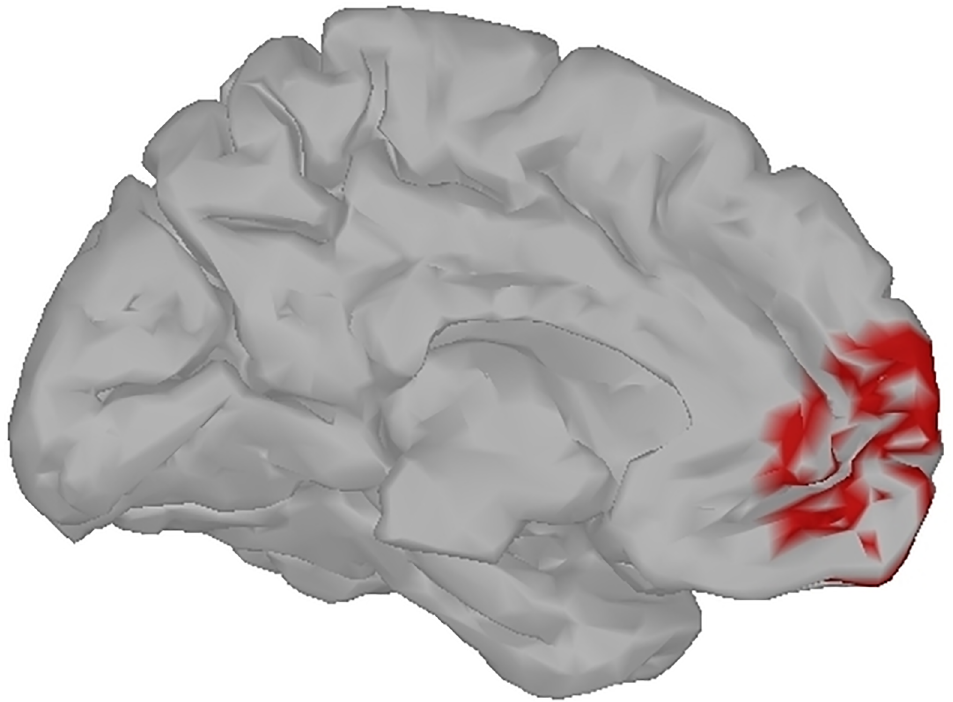
Fig 2. The beamformer target. Left hemispheremedialview: the voxels chosen for the beamformer are shown in red.